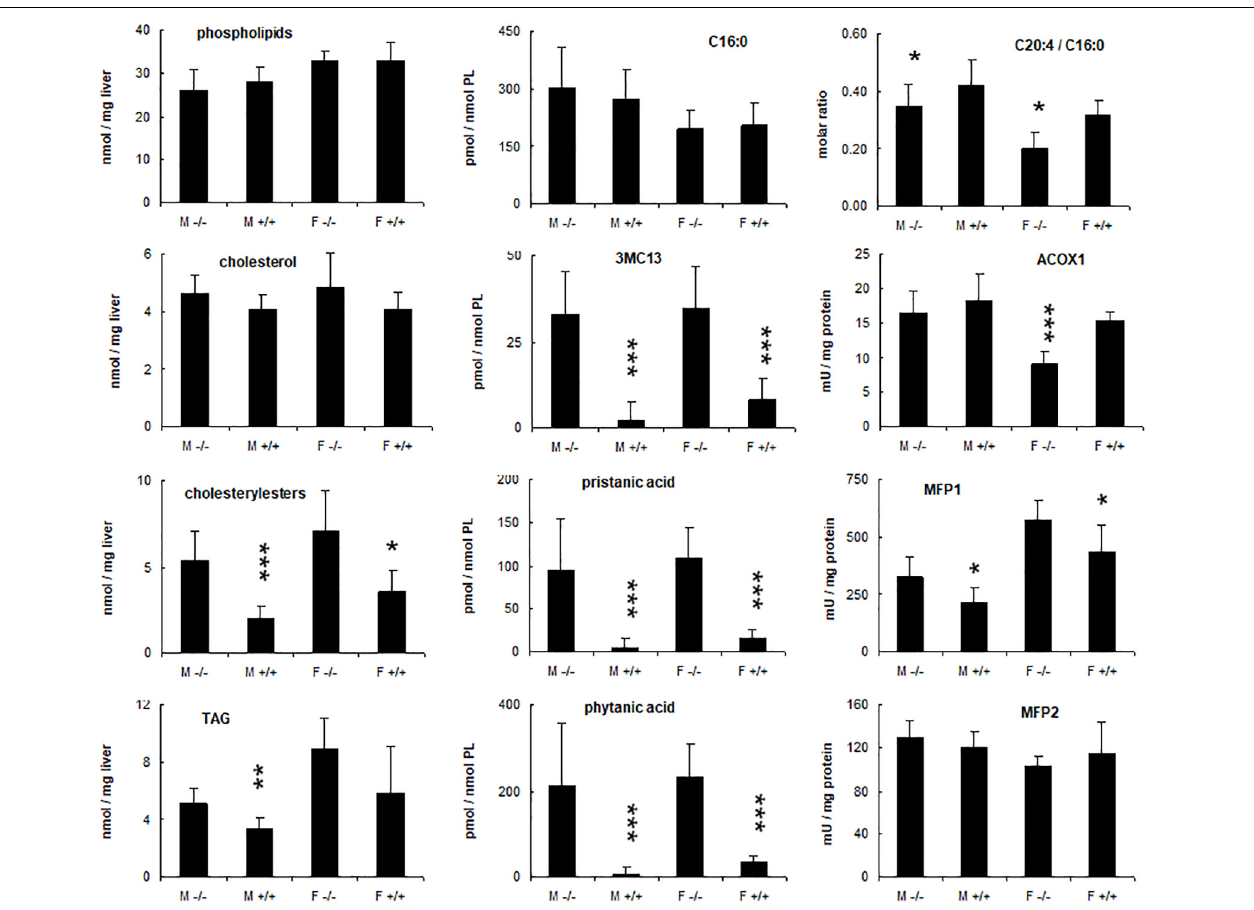
FIGURE 6 | Hepatic changes in phytol treated PMP34 knockout mice. Livers of adult male (M) or female (F) wild type (+/+) or knockout mice (–/–) given a 0.5% phytol enriched diet for 3 weeks were analyzed for protein and lipid content, fatty acid composition, and peroxisomal β -oxidation enzymes. Small amounts of branched fatty acids were present in all +/+ females, but only in one +/+ male animal detected (hence larger SD), whereas severe but variable accumulation was seen in all –/– animals. Arachidonic acid (C20:4) was expressed relative to the amount of palmitic acid (C16:0) per liver. ACOX1 values are several fold higher than in animals receiving a normal diet (see Supplementary Figure S3 ). Values are mean ± SD for 4-6 animals per gender and per genotype, treated in four different feeding studies. Values in heterozygous mice were similar to those in wild type animals (data not shown). Statistical differences are calculated per gender (Oneway ANOVA *** P < 0.005, ** P < 0.01, * P < 0.05 KO versus WT). TAG, triacylglycerides; PL, phospholipid; 3MC13, 4,8,12-trimethyltridecanoic acid; mU,